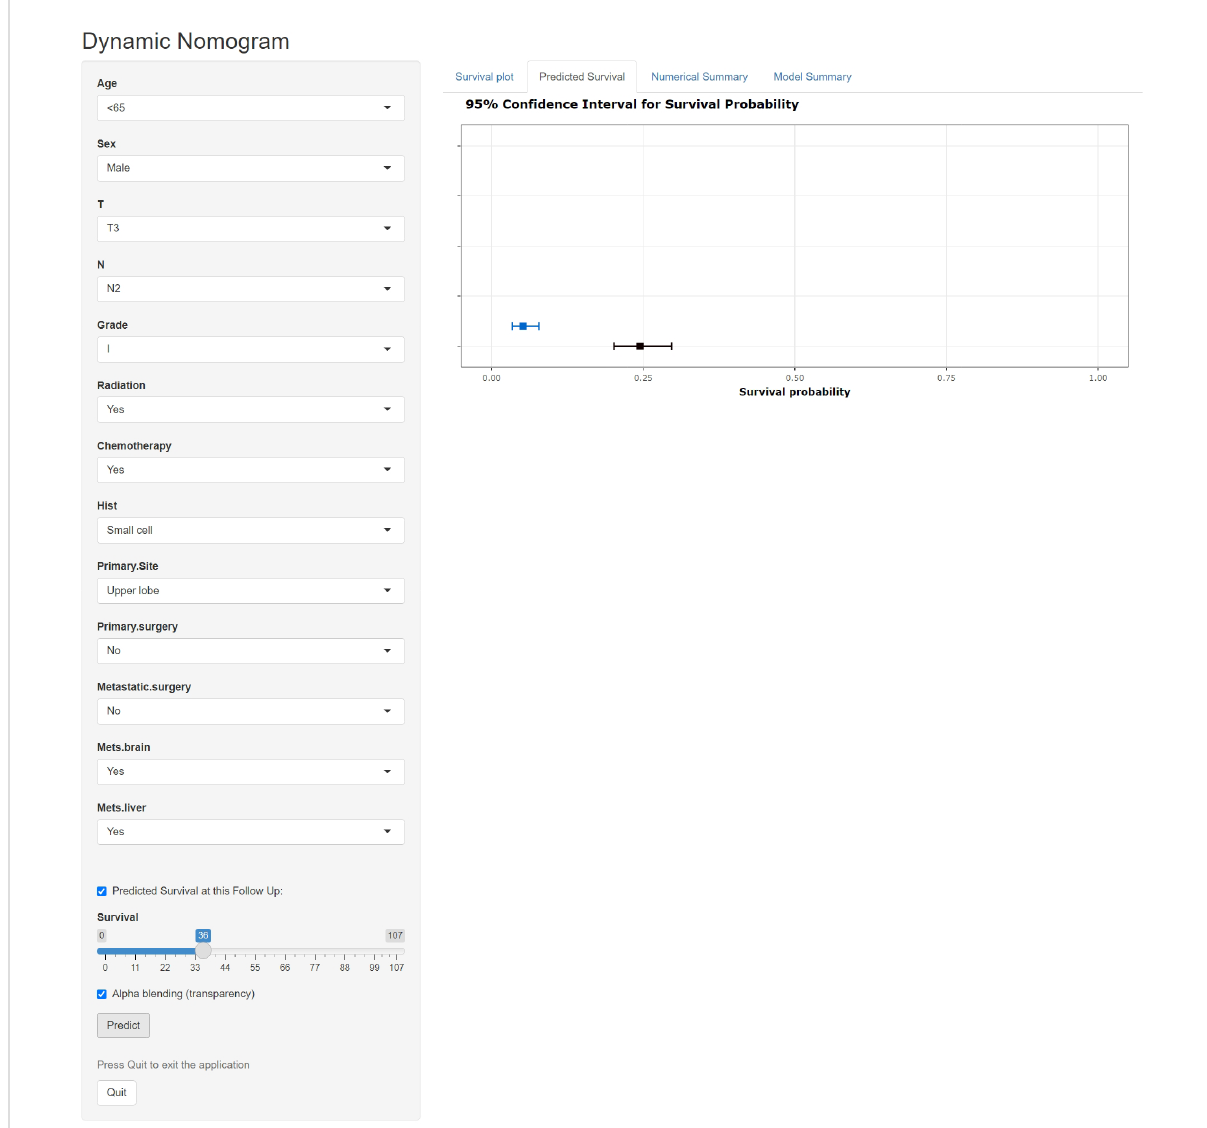
FIGURE 11 A web-based nomogram for predicting postoperative cancer-speci fi c survival (CSS). The line segments of the graphical summary show the approximate range of overall survival